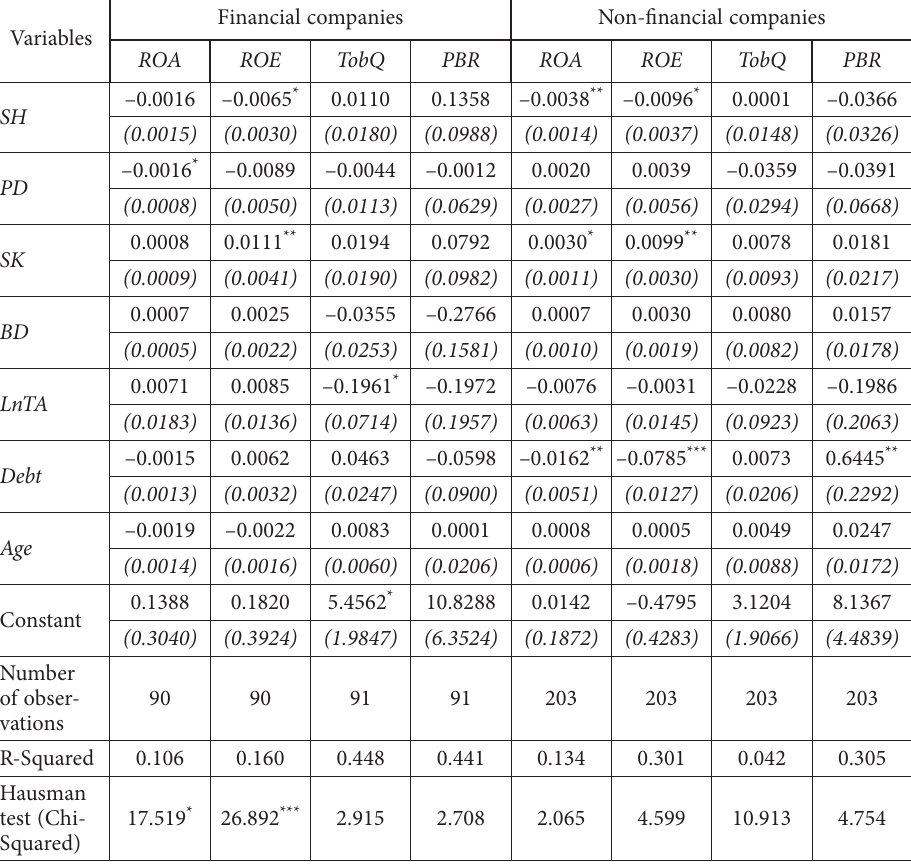
Table 7. Panel least-squares regression results with random effects for reduced samples Va riab